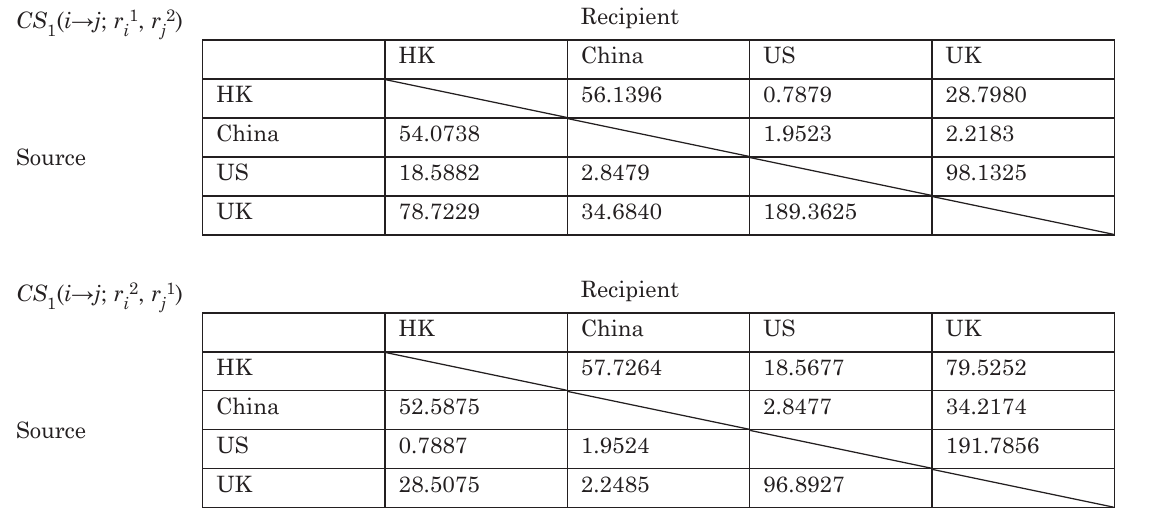
s . the 5% critical value is , i t